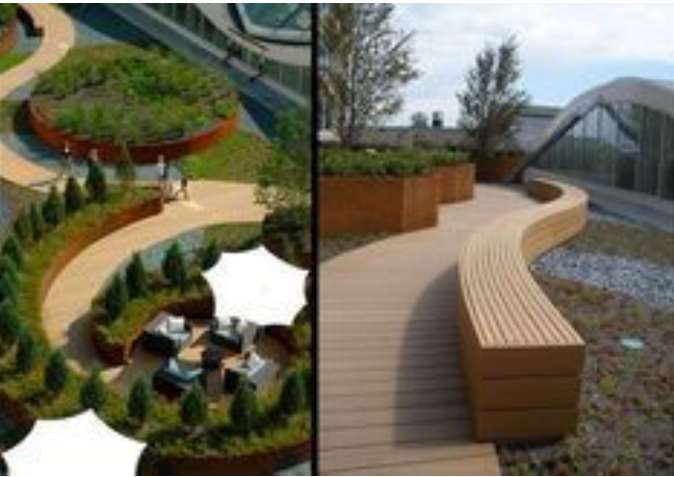
Fig. 3 Parameterised results of architectural landscape